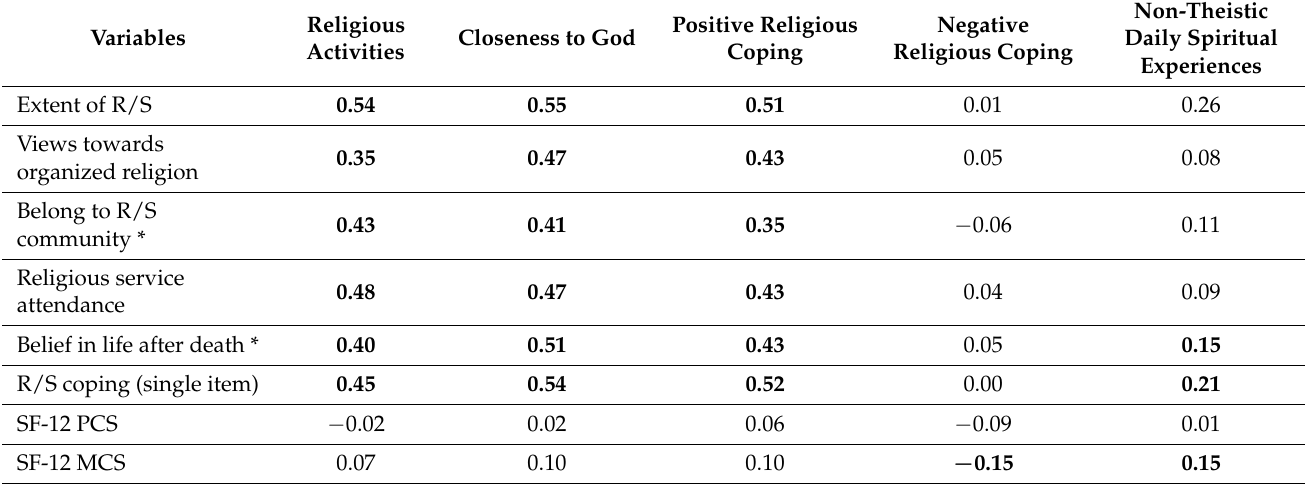
Table 4. Partial Correlations for the SS-1 Scales and Select R/S